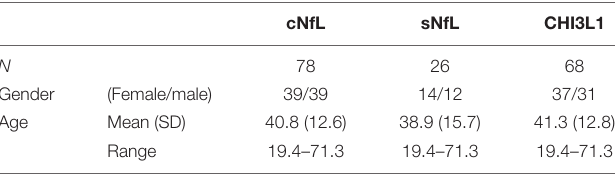
TABLE 3 | Demographic details of healthy cohort, used to derive linear regression models for the biomarker concentrations (cNfL, sNfL, and CHI3L1) with age as an independent variable.